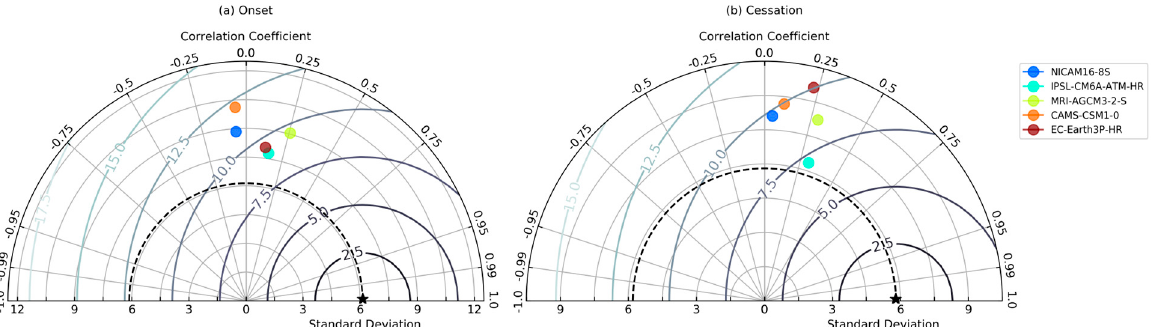
Figure 4. Statistical evaluation of models using Taylor diagram analysis to show the coefficient of correlation, standard deviation, and centred root mean square error for ( a ) onset and ( b ) cessation over region R1. Different coloured dots represent different datasets as described in the legend. Five-pointed star represents the observational dataset.